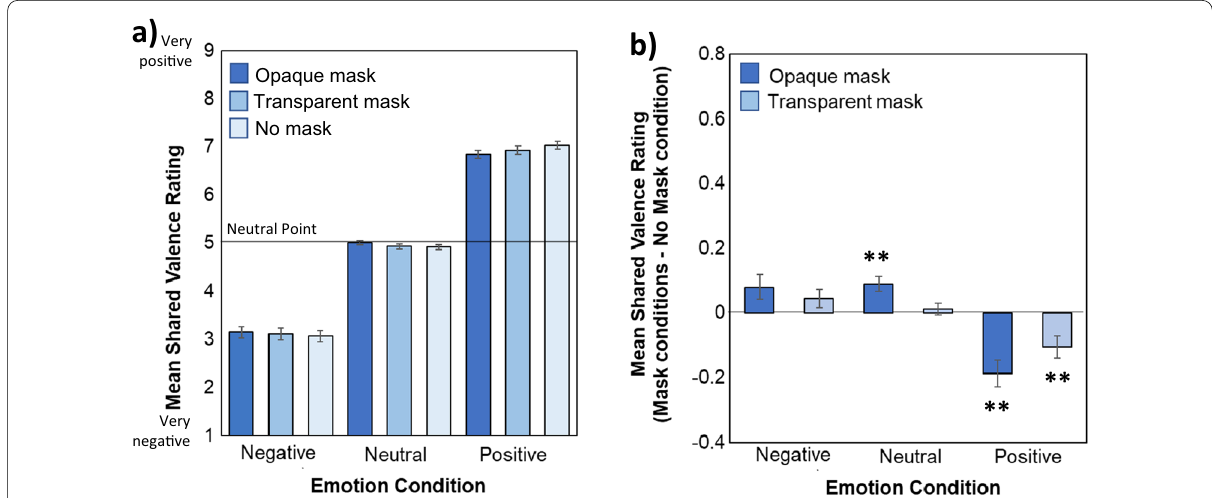
Fig. 5 a Ratings of emotional valence shared with the protagonist during each Emotion and Mask condition on a scale from 1/very negative to 9/ very positive. b Comparison of shared valence ratings for protagonists wearing opaque and transparent masks relative to those with no masks for each Emotion condition (calculated by subtracting the no mask from each mask condition). Larger bar magnitude indicates a larger difference from the No mask condition, with ** indicating a significant difference from the no mask baseline at p < .01. Error bars represent standard error of the